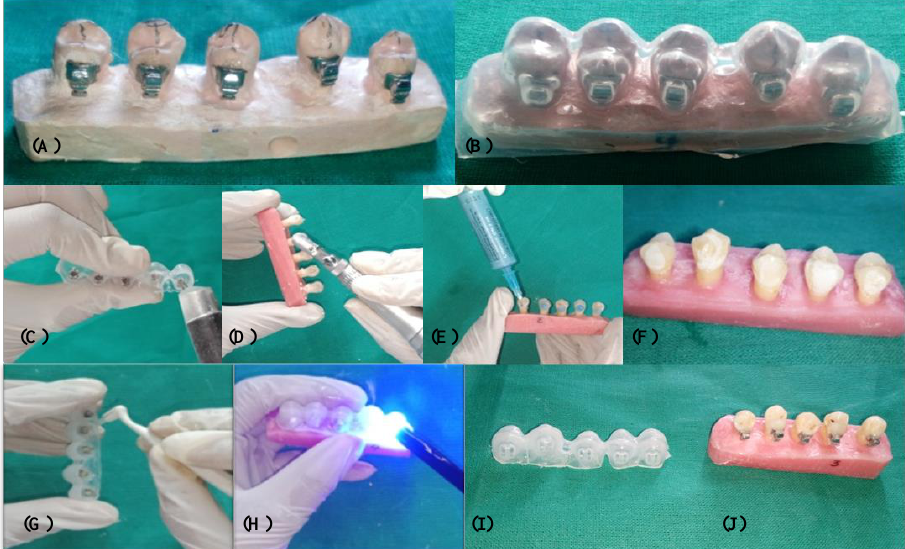
Fig 5. Procedure involved in Indirect bonding on the lingual surface of teeth. (A) working model with bonded brackets. (B) Fabrication of transfer tray. (C) Sandblasting of the bracket base. (D) Preparation of the tooth surface by pumicing. (E) Application of etchant on teeth surface. (F) The frosty white appearance of the teeth’ surface. (G) Application of the adhesive and primer on the bracket base. (H) Curing of brackets over the occlusal tray. (I) Transfer tray with brackets. (J) Indirectly bonded brackets on the lingual surface of the mounted